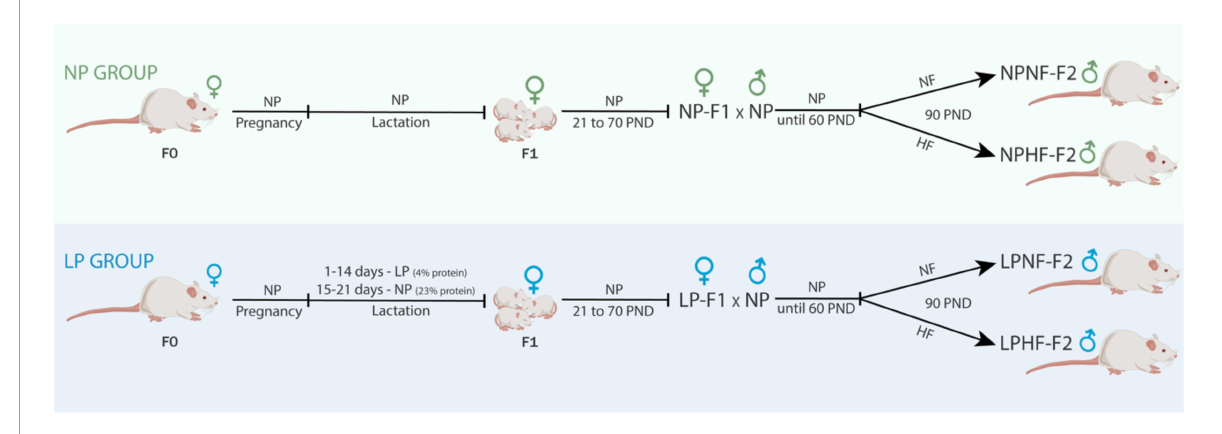
FIGURE1 Experimental design. NP, normal-protein diet; LP, low-protein diet; NF, normal-fat diet; HF, high-fat diet; PND, post-natal day.